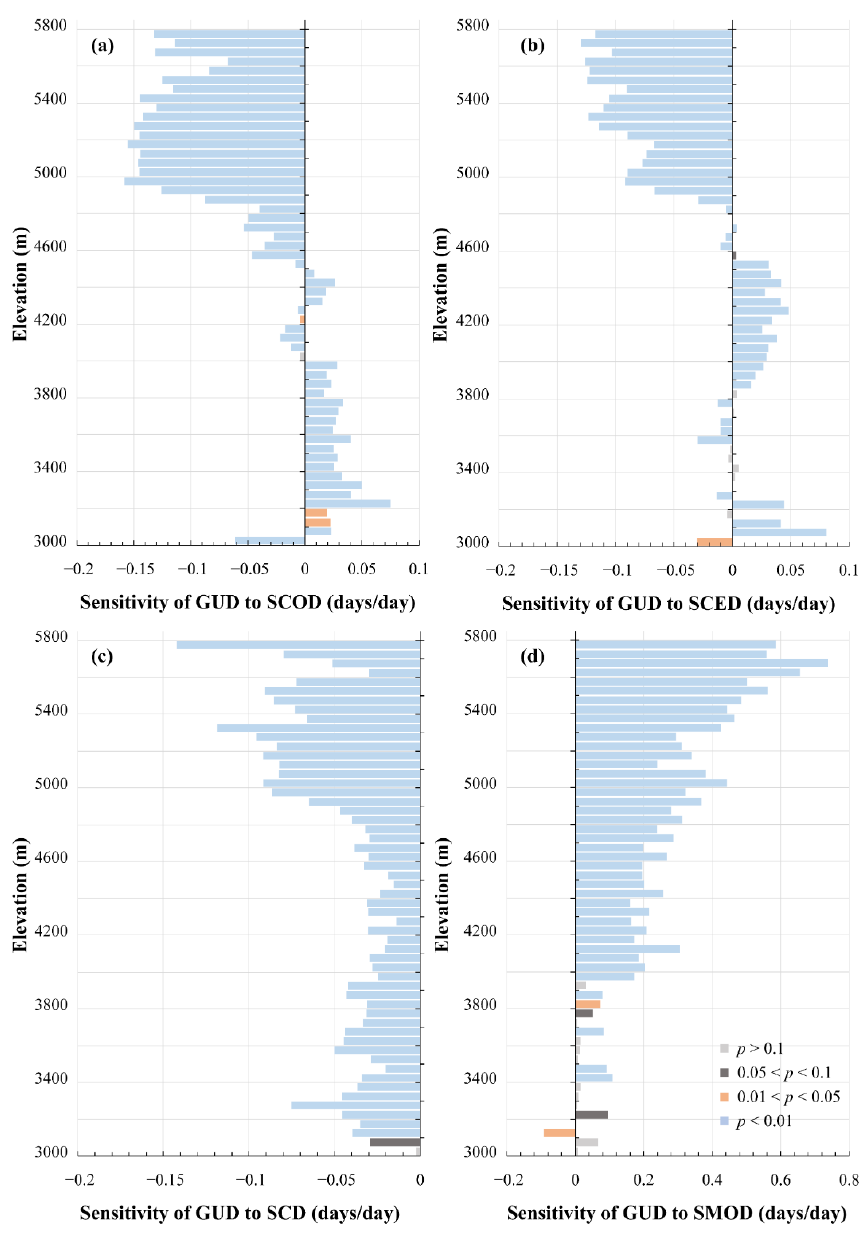
Figure 8. Elevational variation of the sensitivity of GUD to ( a ) SCOD, ( b ) SCED, ( c ) SCD, and ( d ) SMOD for the pixels with a significant correlation ( p < 0.01).